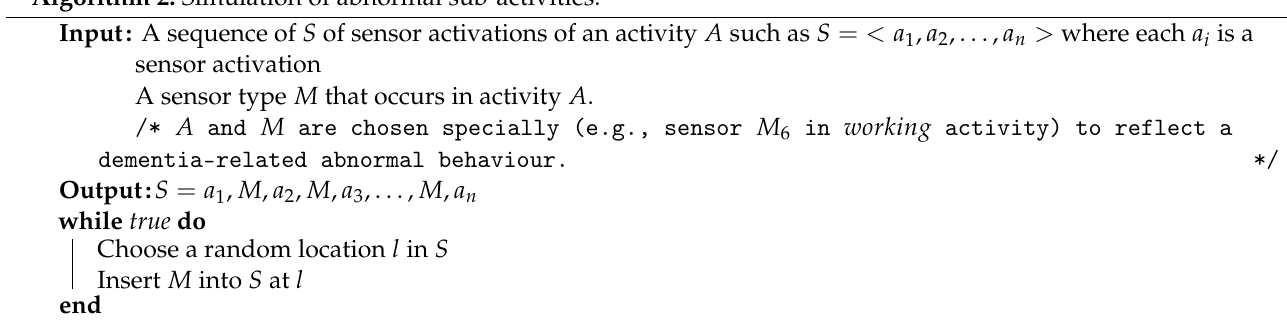
Algorithm 2: Simulation of abnormal